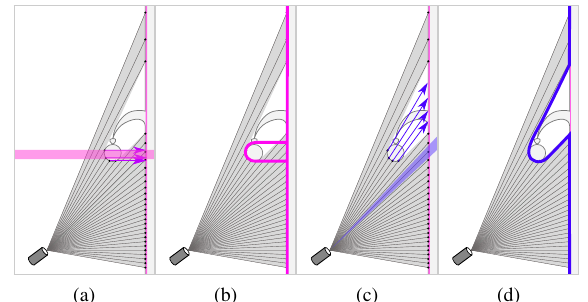
Figure 9: The facade in profile and a wall light are sketched. The points are accumulated on the vertical plane, according to an orthogonal projection (a), (b) and a prismatic projection (c), (d). Orthogonal projection leads to accumulating points from distant beams in a same pixel (a), causing an ambiguity in the choice of the surface (b). prismatic projection is more consistent with the scan (c) and leads to a surface reconstruction with less ambiguity (d).